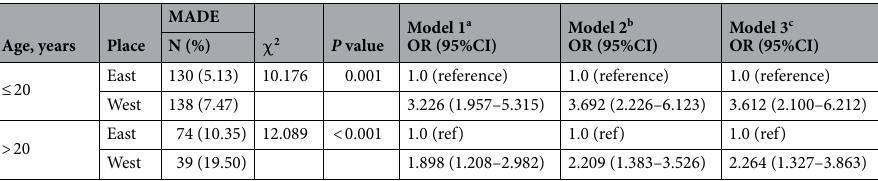
Table 3. MADE incidence according to geographic location (West and East areas) and